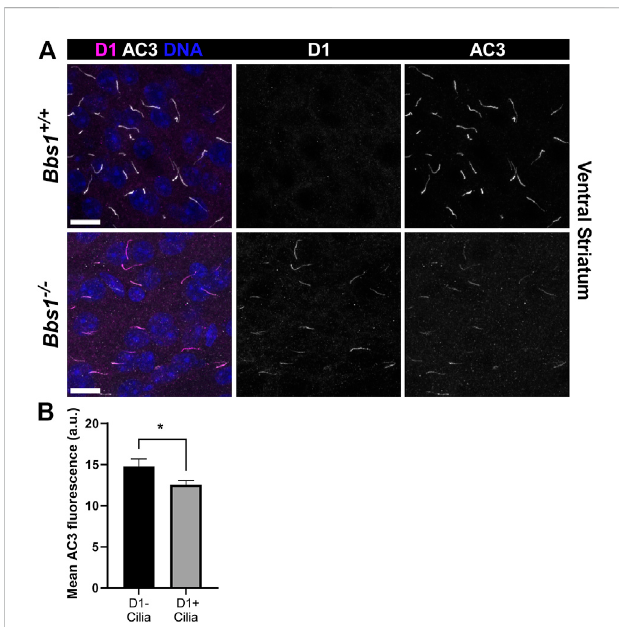
FIGURE 2 D1 accumulates in cilia in the brains of Bbs1 − / − mice and is associated with a reduction in AC3 ciliary signal (A) Representative imagesoftheventralstriatum fromadult Bbs1 +/+ (upperrow)and Bbs1 − / − (lower row) mice colabeled for D1 (magenta) and AC3 (white). D1 localized to 0% (0/739; n = 3 animals) of AC3-positive cilia in Bbs1 +/+ sectionsand64%(279/434; n =3animals)ofAC3-positiveciliain Bbs1 − / − sections. Nuclei are stained with DRAQ5 (blue). Scale bars represent 10 µm (B) Quanti fi cation of mean ciliary AC3 fl uorescence in D1- negative( n =100)andD1-positive( n =194)ciliain Bbs1 − / − sections.Note that the AC3 signal is signi fi cantly lower in D1-positive cilia. Values are expressed as mean ± SEM. * p <